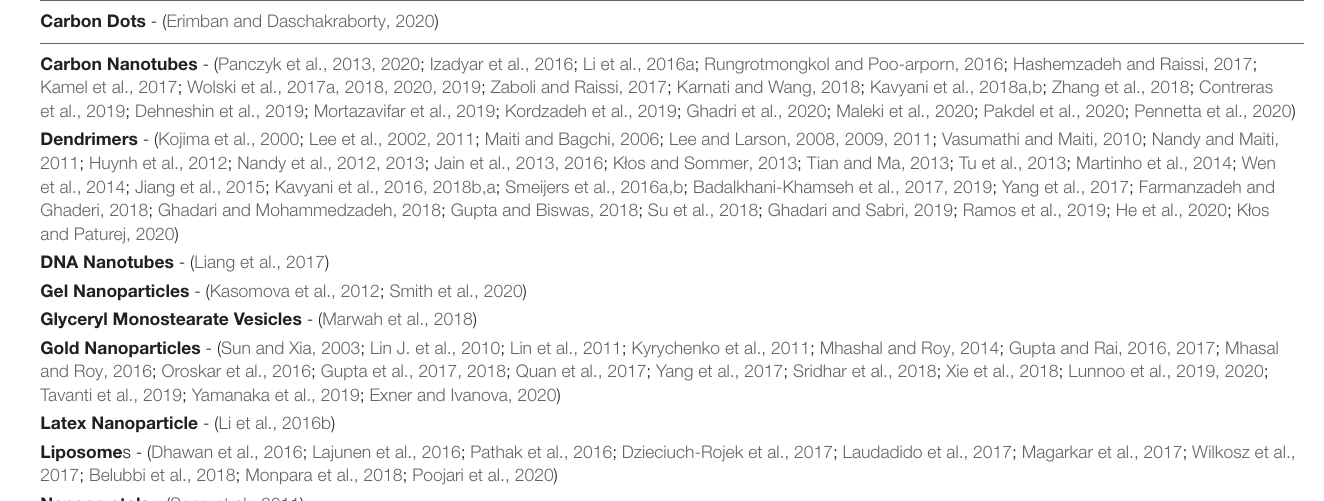
TABLE 2 | Drug delivery vehicles studied using molecular modeling methods. Carbon Dots - (Erimban and Daschakraborty,